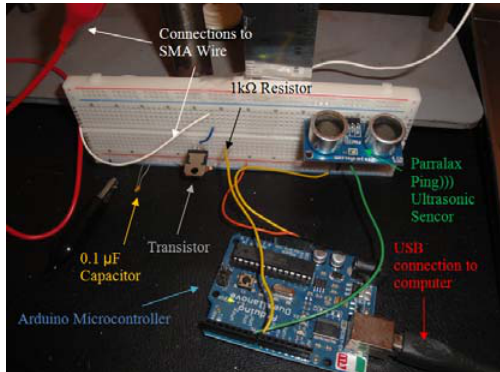
Figure 3. A close-up of the testing apparatus’s electronic